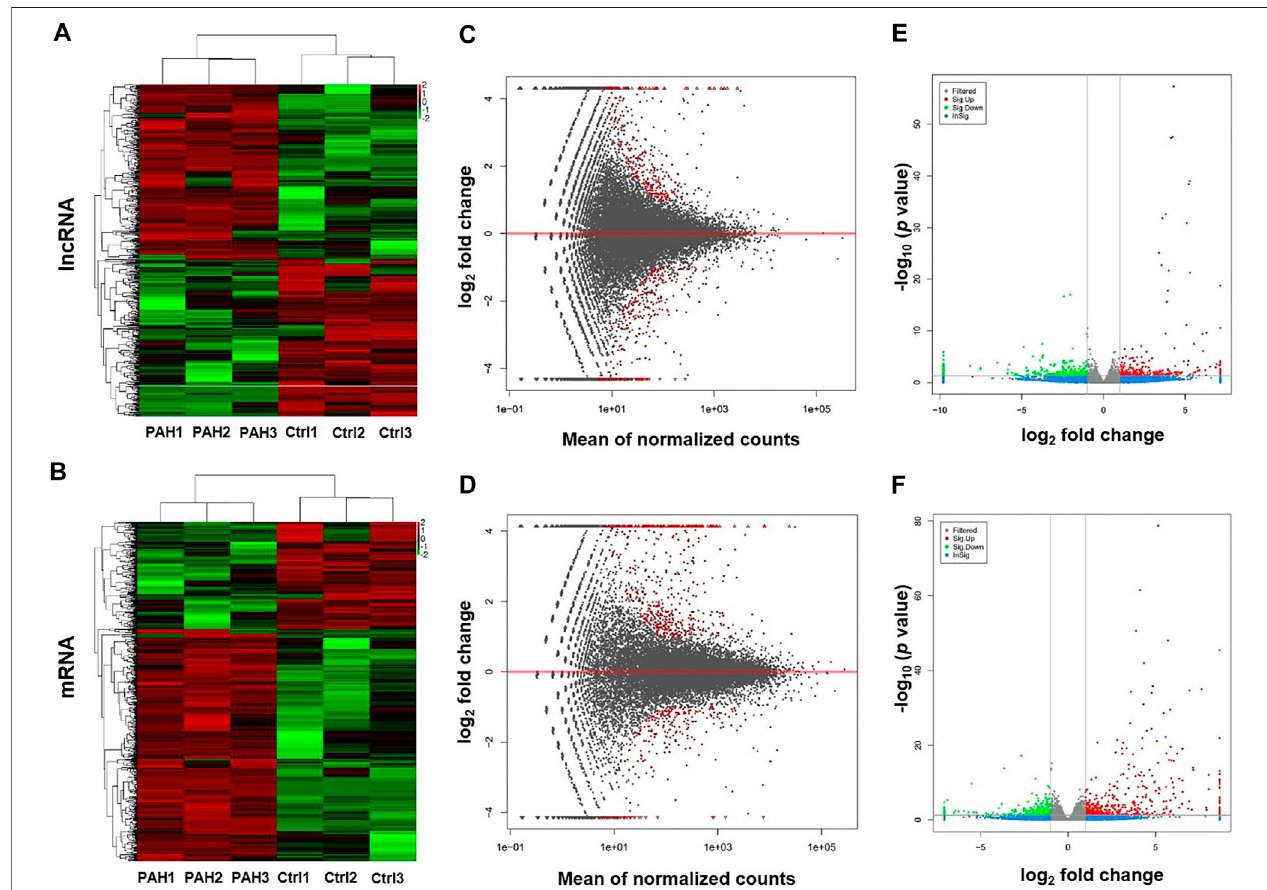
FIGURE1| Pro fi lingoflncRNAs andmRNAsbetweenPAH groupandcontrolgroup. (A,B) Heatmaps showedthehierarchicalclusteringofdifferential expression in lncRNAs and mRNAs between PAH group (PAH) and control group (Ctrl). (C,D) MA plots showed the differential expression of lncRNAs and mRNAs between two groups. Differential expression was indicated as “ red ” . (E,F) Volcano plots were depicted to visualize the up-regulated and down-regulated lncRNAs and mRNAs between two groups. Up-regulated expression was indicated as “ red ” , and down-regulated expression was indicated as “ green ” .